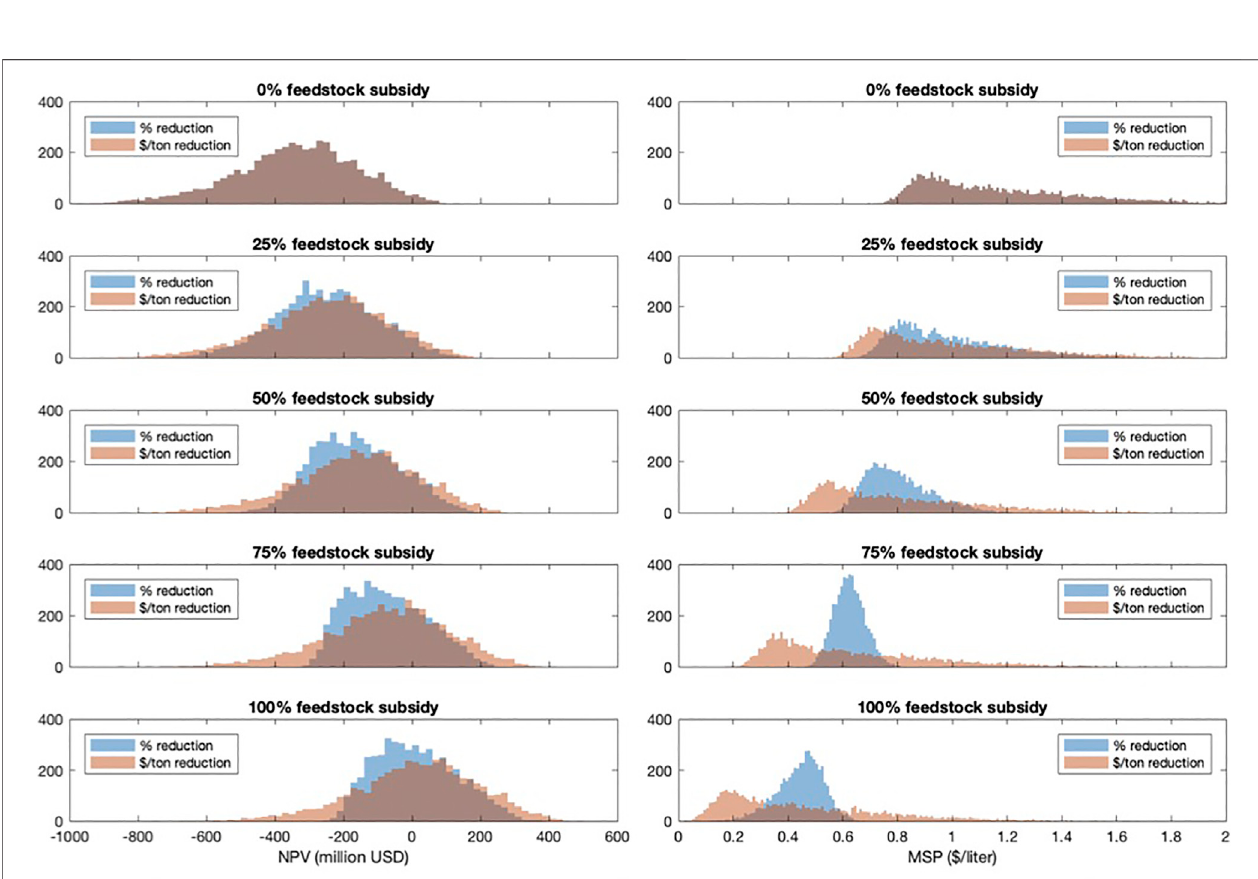
FIGURE 4 | Histograms of feedstock subsidy as a percentage subsidy from 0 – 100% compared to an equivalent fi xed $/short ton value.